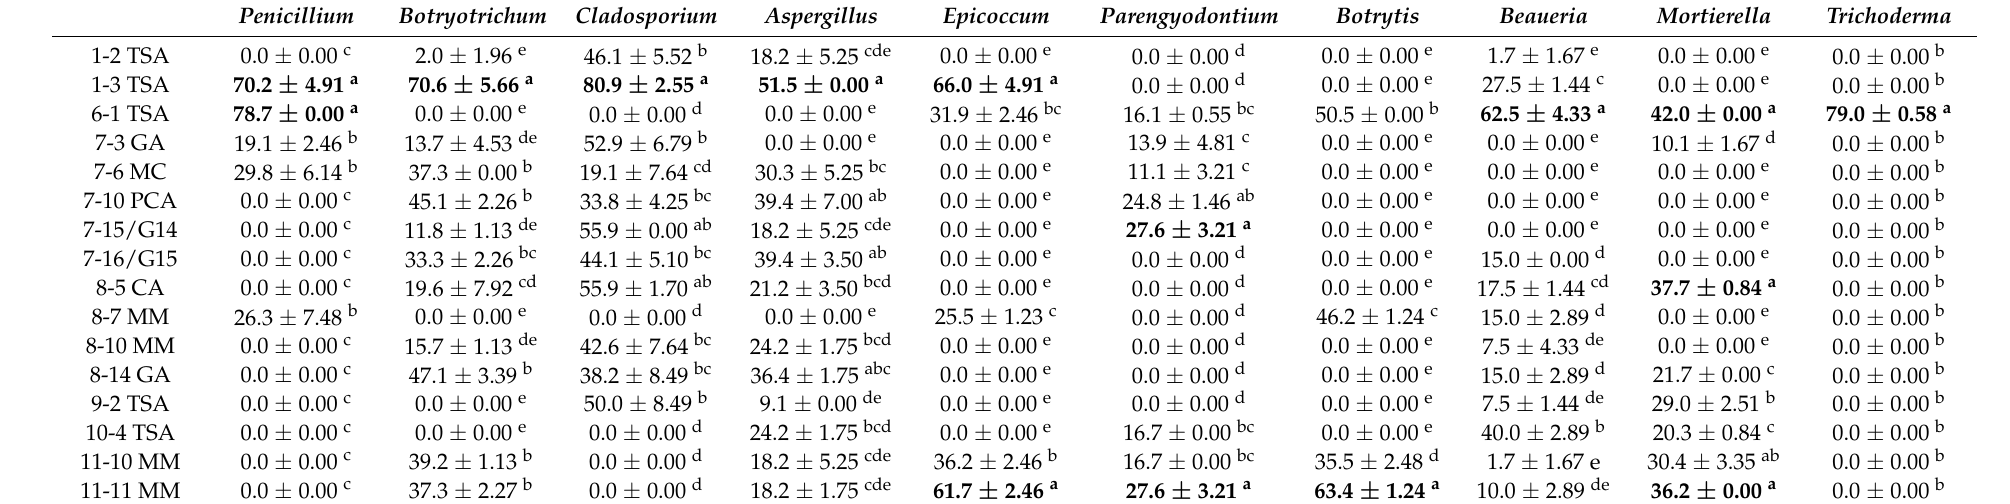
Table 3. Antifungal activity in vitro of selected antagonistic bacterial isolates against biodeteriogenic fungi. Penicillium Botryotrichum Cladosporium Aspergillus Epicoccum Parengyodontium Botrytis Beaueria Mortierella